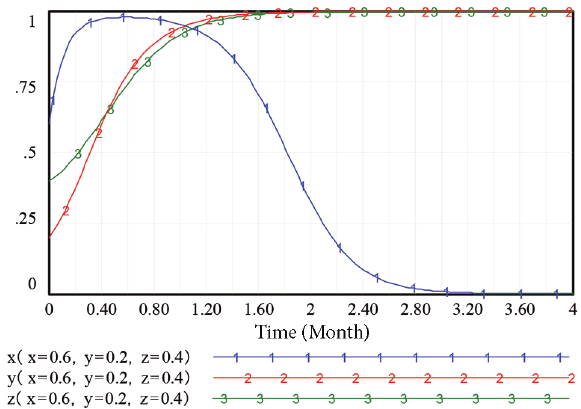
Figure 14. Game results under dynamic penalty–reward